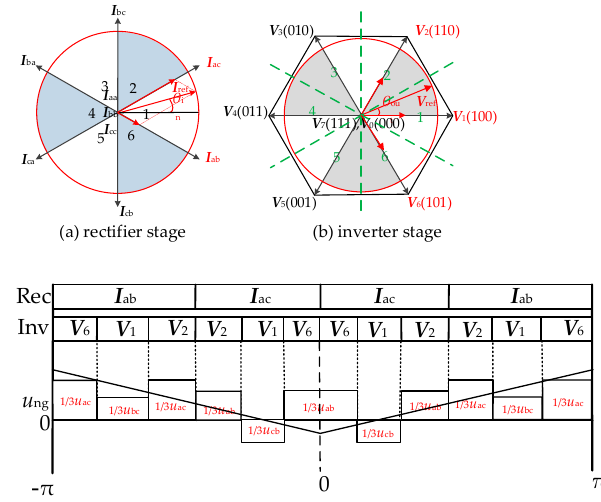
Figure 6. Modulation principle and vector distribution of method 2.